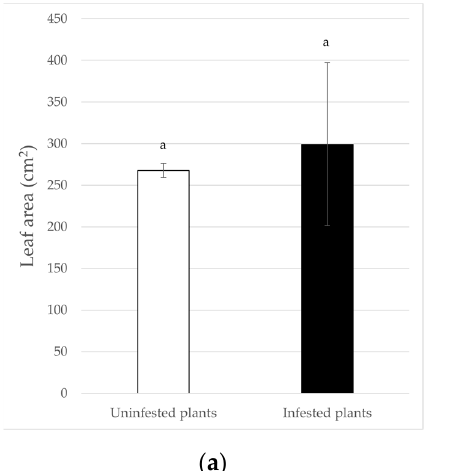
Figure 4. Incidence of B. tabaci infestation on the height ( a ) and shoot dry weight ( b ) of eggplant plants. Different letters indicate statistically significant differences at p < 0.01.